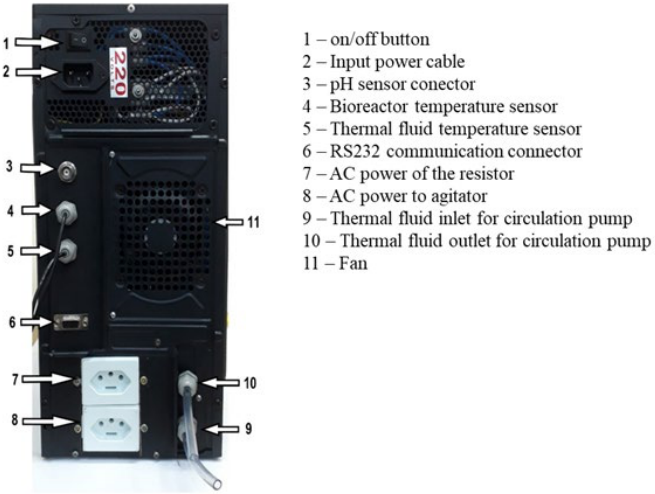
Figure 5. Rear view of control unit.